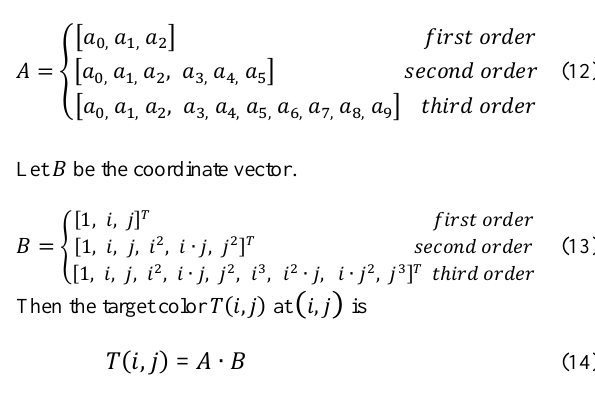
differences between images.